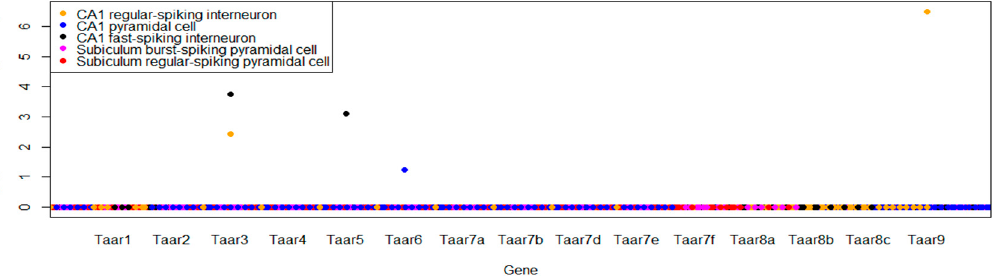
Figure 4. Distribution of TAARs expression in the murine hippocampal cell populations in the dataset GSE75386. Different cell types are macked by color.